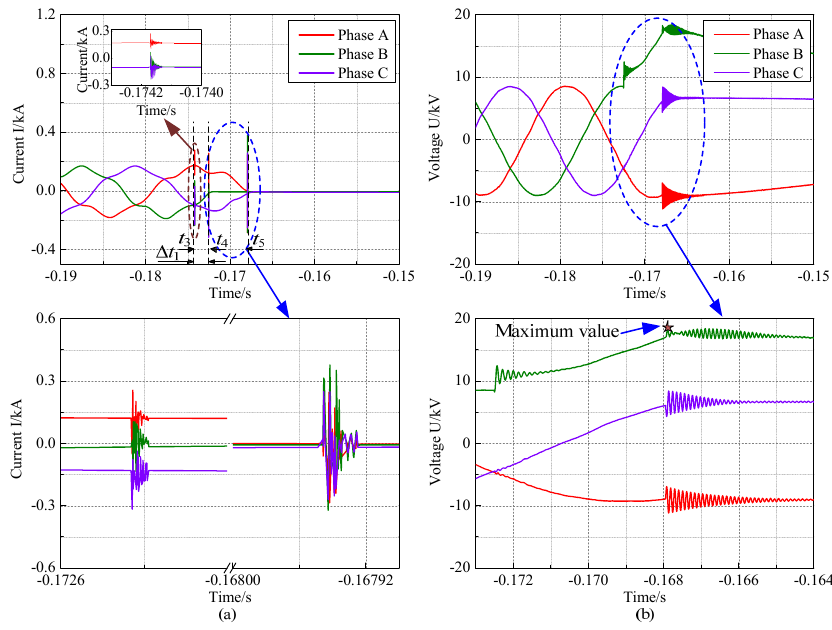
Figure 11. Waveforms of the opening current and capacitor voltage in Case 4. ( a ) Current waveform; and ( b ) voltage waveform.